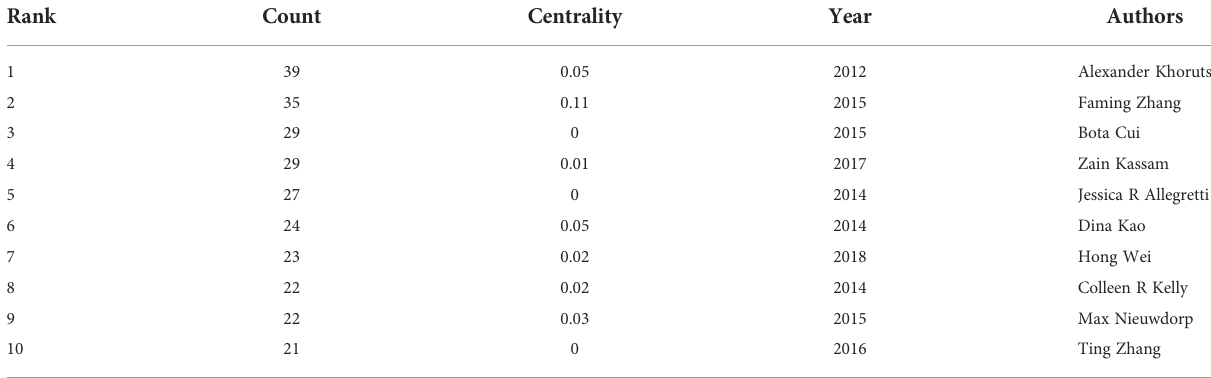
TABLE 3 Top 10 productive authors of FMT-related research articles.